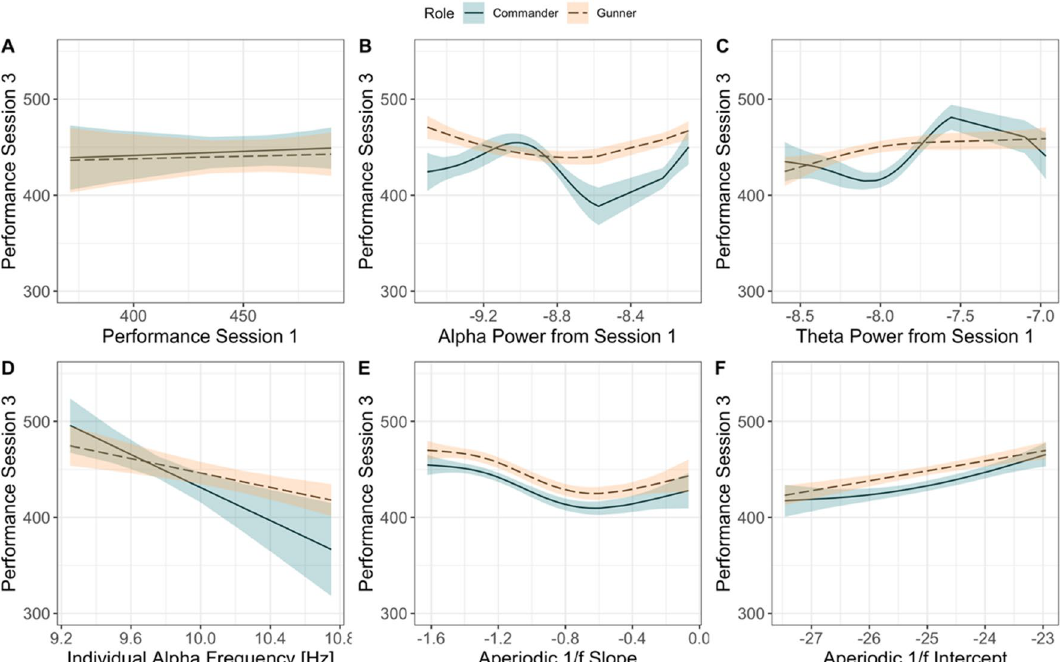
Figure 5. Modelled effects of behavioural, task-related, and resting-state-derived EEG activity on behavioural ratings from session three for the simulated tank task at Armoured (most difficult scenario; represented on the y-axis, with higher values indicating better